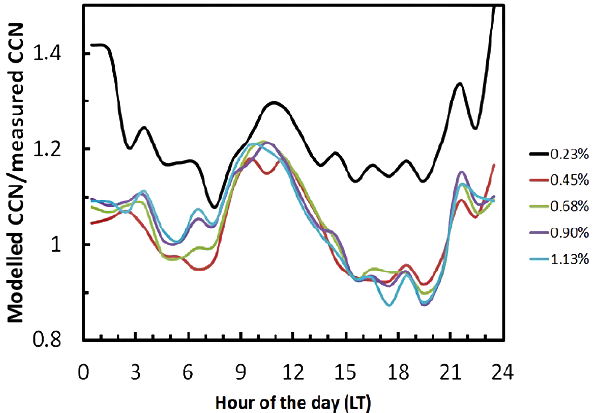
Figure 8. Mean value of modelled N CCN /observed N CCN for dif- ferent supersaturations as a function of local